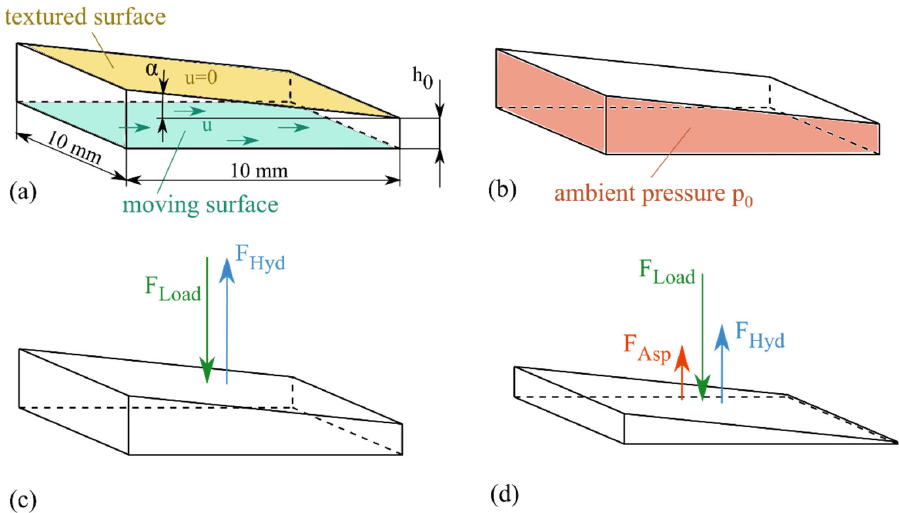
Figure 1. ( a ) Dimensions and velocity boundary conditions of the lubrication gap, ( b ) pressure boundary condition, ( c ) force equilibrium for hydrodynamic lubrication, ( d ) force equilibrium for mixed lubrication.